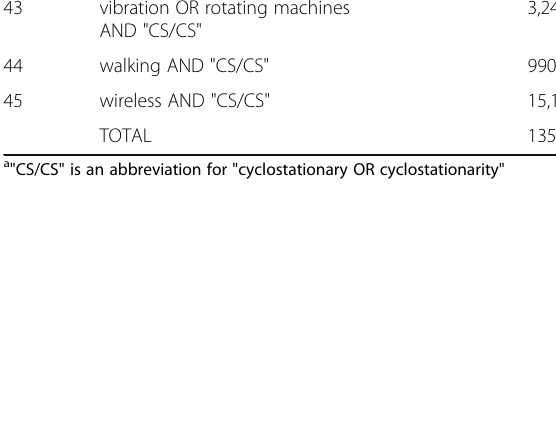
Table 2 Partially-Redundant General Subjects